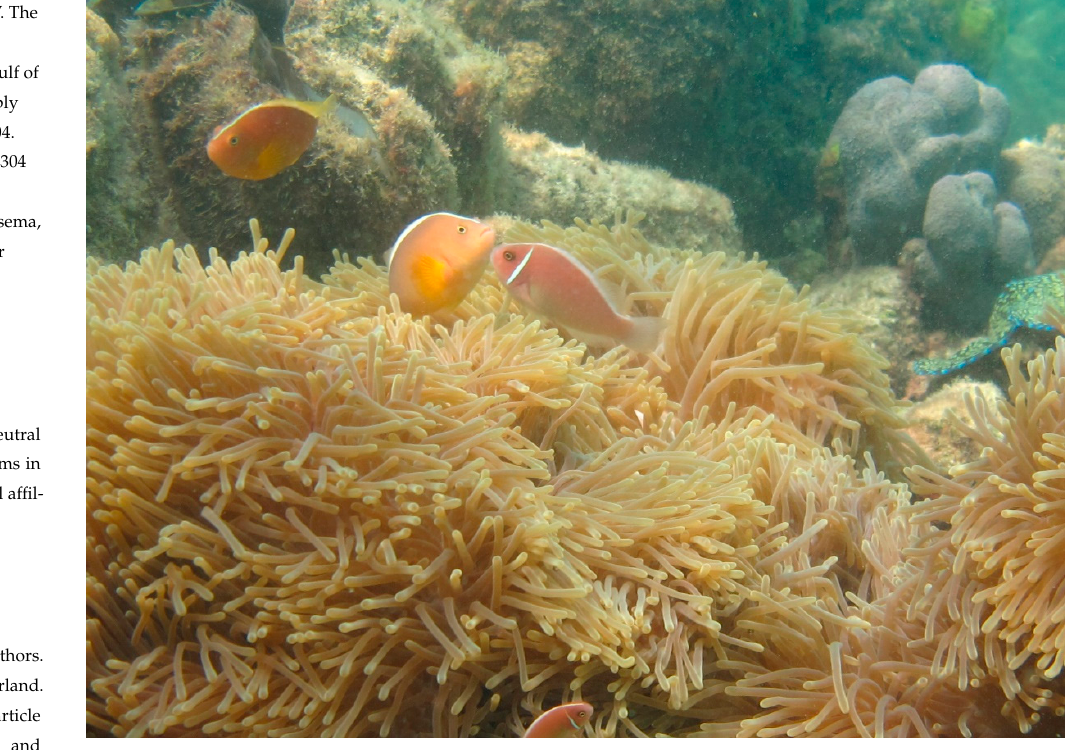
Figure 1. Skunk anemonefish ( Amphiprion akallopisos ) and pink anemonefish ( Amphiprion perideraion ) sharing the magnificent sea anemone. The primary difference in coloration between skunk and pink anemonefish is the vertical white head bar behind the eye of the latter species.